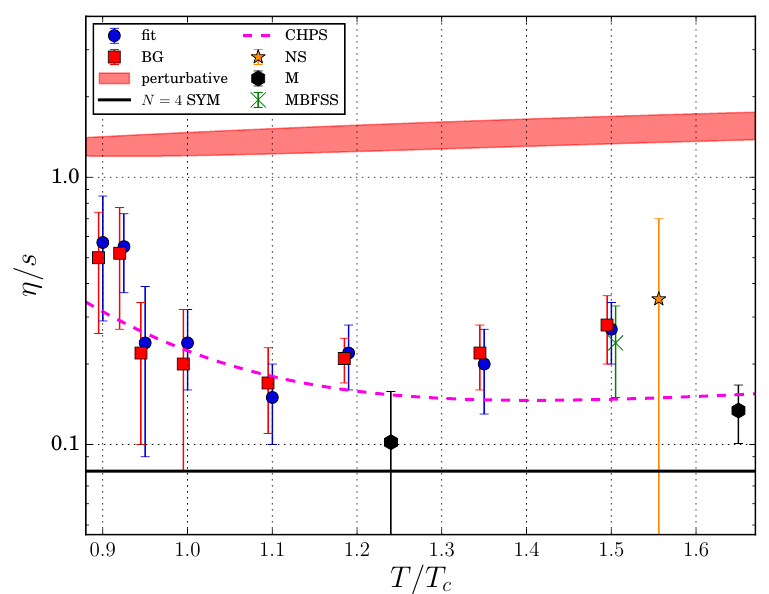
Figure 5 . The ratio (cid:17)=s in gluodynamics for various temperatures. The circle blue points cor- respond to the results obtained within the (cid:12)tting procedure and the square red points correspond to the BG method. We also plot the previous lattice results obtained by A. Nakamura, S. Sakai in [14] (the yellow star point), by H.Meyer in [15] (the black hexagonal points) and by S. Mages, S. Bors(cid:19)anyi, Z. Fodor, A. Sch(cid:127)afer, K. Szab(cid:19)o in [17] (the green cross point). In addition we plot